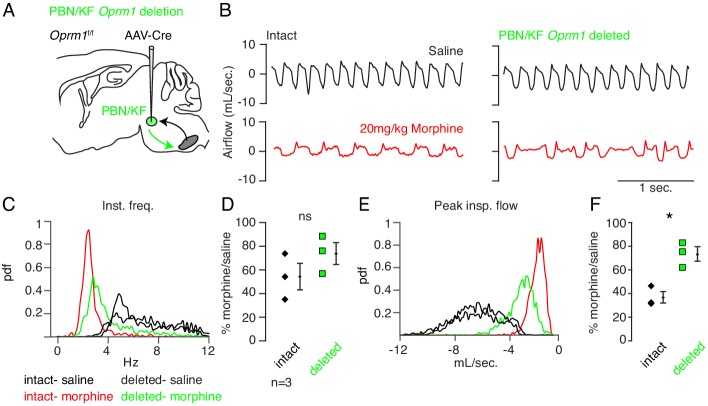
Necessity of Parabrachial/Kolliker Fuse nuclei in opioid-induced respiratory depression.(A) Schematic of a sagittal section through the adult mouse brain. Oprm1 is expressed by neurons within the pontine Parabrachial/Kolliker Fuse (PBN/KF) which has modulatory input into the preBötC (Chamberlin and Saper, 1994; Alheid et al., 2004) and is a proposed region for respiratory depression during OIRD (Smith et al., 1991; Feldman et al., 2013). As in Figure 2, breathing was assayed before and after Cre-virus injection into the PBN/KF of Oprm1f/f mice. (B) Representative examples of the breathing airflow (mL/sec.) in hypercapnia after saline (black) or morphine (red) before and after Cre-virus injection. (C–D) Probability density function plot of the instantaneous respiratory frequency for a representative animal (C) and ratio of average rate (D) p-value=0.4, Cohen’s d = 0.62) after IP injection of morphine-to-saline for 3 animals before (pre) and after (post) Cre-virus injection into the PBN/KF. (E–F) Probability density function plot of the peak inspiratory airflow for a representative animal (E) and ratio of average peak inspiratory airflow (F) p-value=0.02, Cohen’s d = 1.68) after IP injection of morphine-to-saline for 3 animals before (pre) and after (post) Cre-virus injection into the PBN/KF. * indicates p-value<0.05. ns indicates p-value>0.05.Figure 3—figure supplement 2—source data 1.Average frequency, peak flow and pause duration after intraperitoneal saline or morphine in hypercapnia at baseline or after Oprm1 deletion from the PBN/KF.